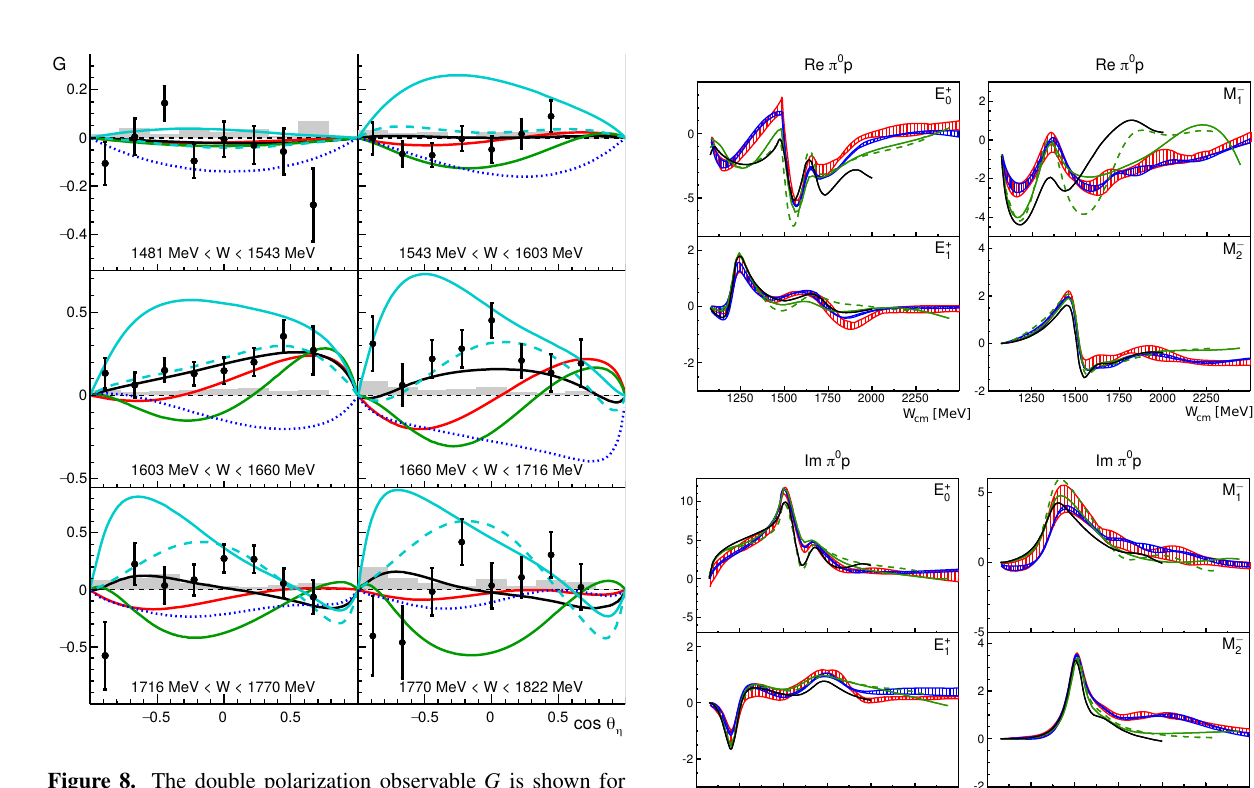
Figure 8. The double polarization observable G is shown for the p η final state (black points) together with di ff erent PWA so- lutions (latest fit of BnGa (black line) [40], BnGa2011-02 (red line) [42], η MAID2018 (green line) [48], SAID-GE09 (dark blue dotted) [49], JüBo-2015 (light blue dashed line) [50] and JüBo- 2015-3 (light blue solid line) [51]). Taken from [14].